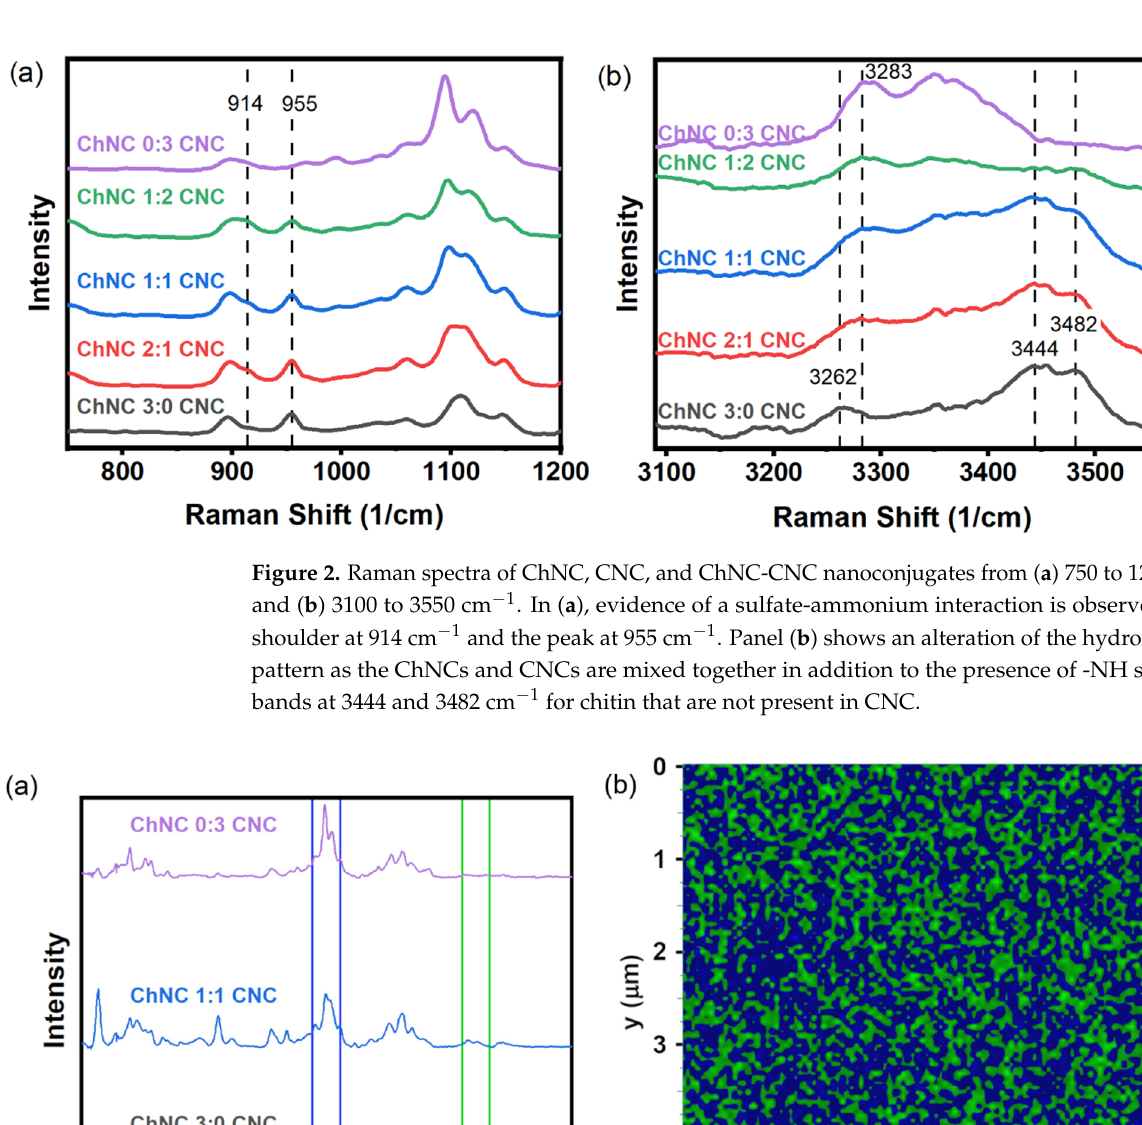
Figure 2. Raman spectra of ChNC, CNC, and ChNC-CNC nanoconjugates from ( a ) 750 to 1200 cm − 1 , and ( b ) 3100 to 3550 cm − 1 . In ( a ), evidence of a sulfate-ammonium interaction is observed by the shoulder at 914 cm − 1 and the peak at 955 cm − 1 . Panel ( b ) shows an alteration of the hydrogen bond pattern as the ChNCs and CNCs are mixed together in addition to the presence of -NH stretching bands at 3444 and 3482 cm − 1 for chitin that are not present in CNC.